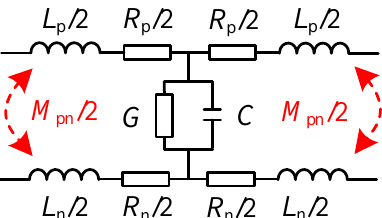
Figure 7. Equivalent model of laminated busbar circuit.